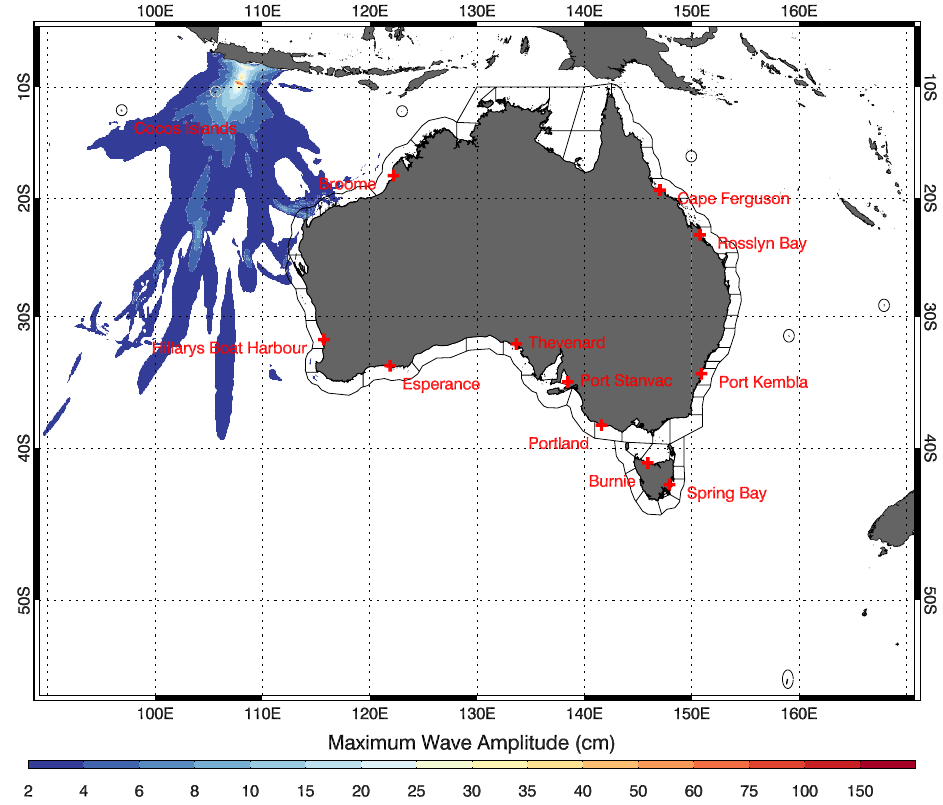
Fig. 1. An example of a map of H max from a T2 scenario. Also shown are the coastal zones used in this study. The coastal zones not bordering the Australian mainland or Tasmania are shown larger than scale for clarity. The locations of the tide gauges used in this study to design the retrospective warning schemes are also